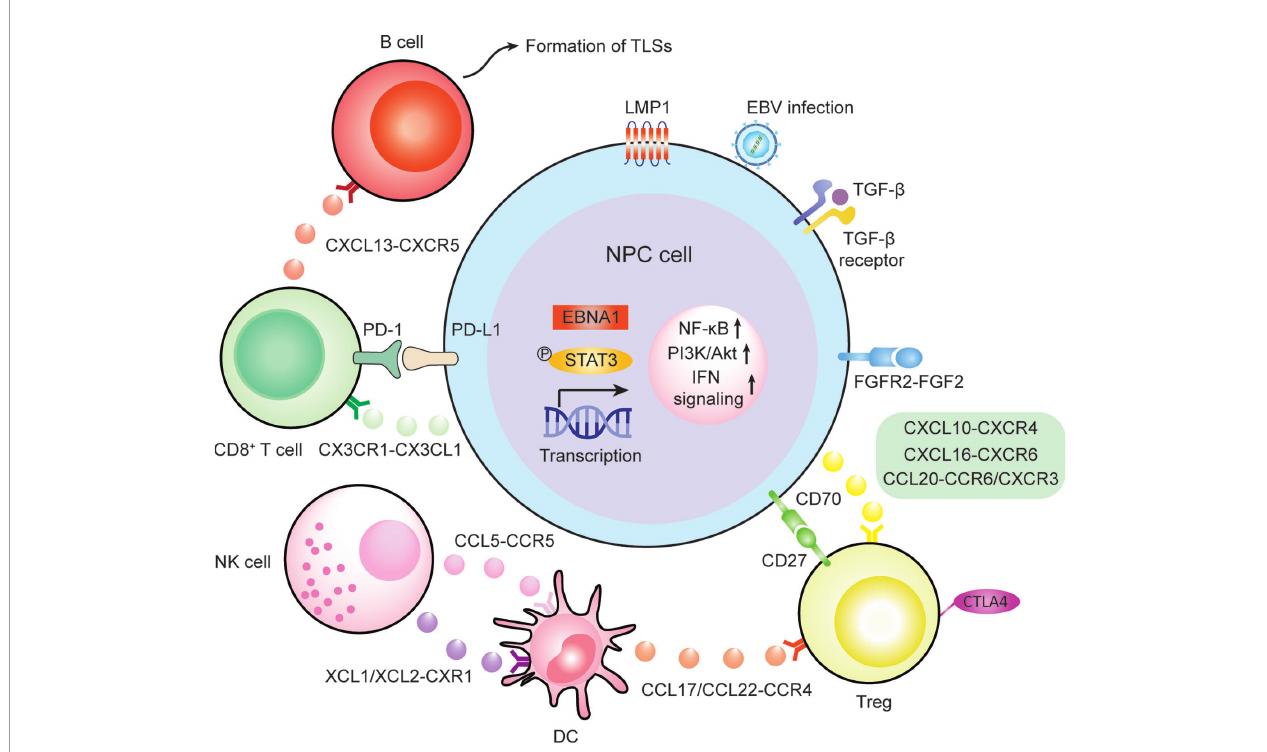
FIGURE 2 | The schematic illustration of cell recruitment and cell-cell interactions in the NPC